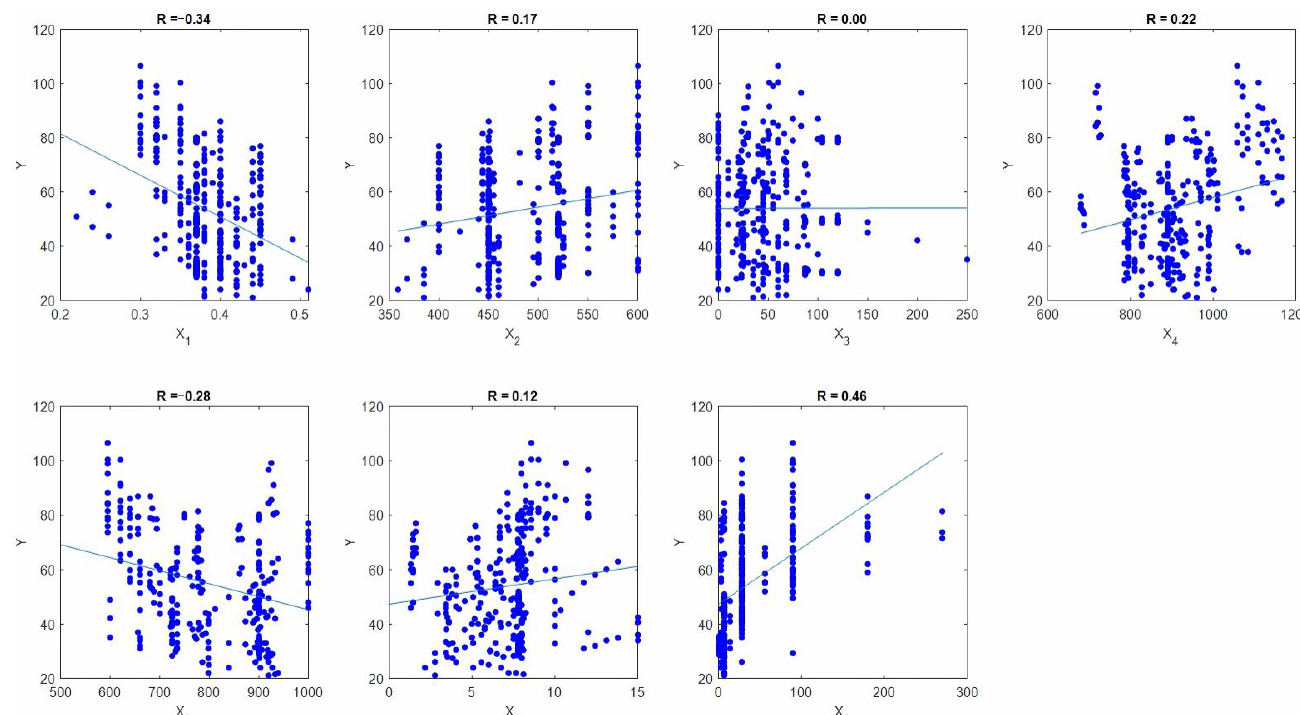
Figure 3. Scatter plots of variables in Dataset 3.